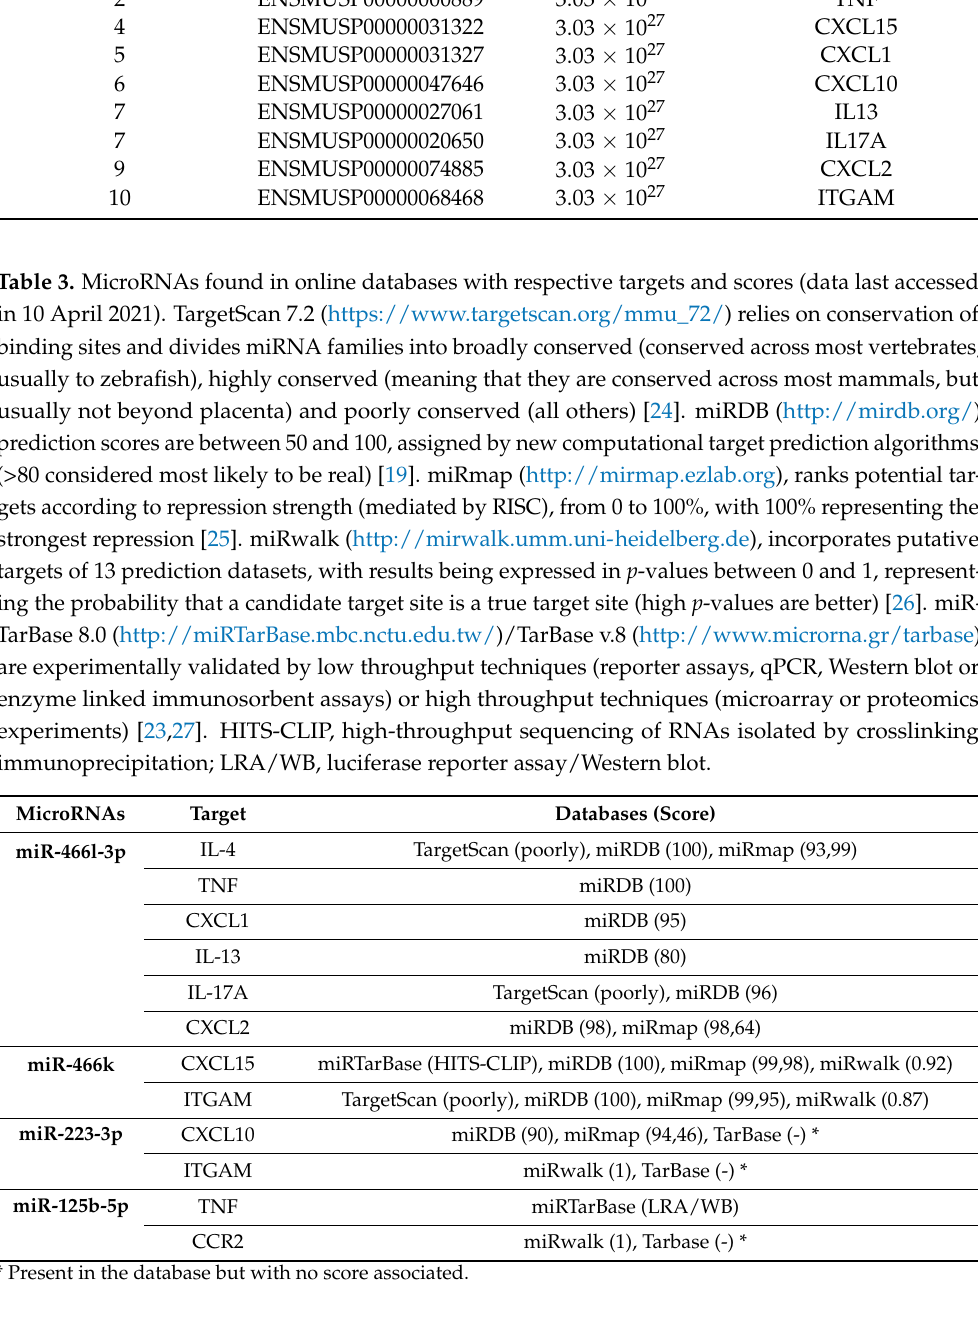
Table 2. Top 10 hub proteins.